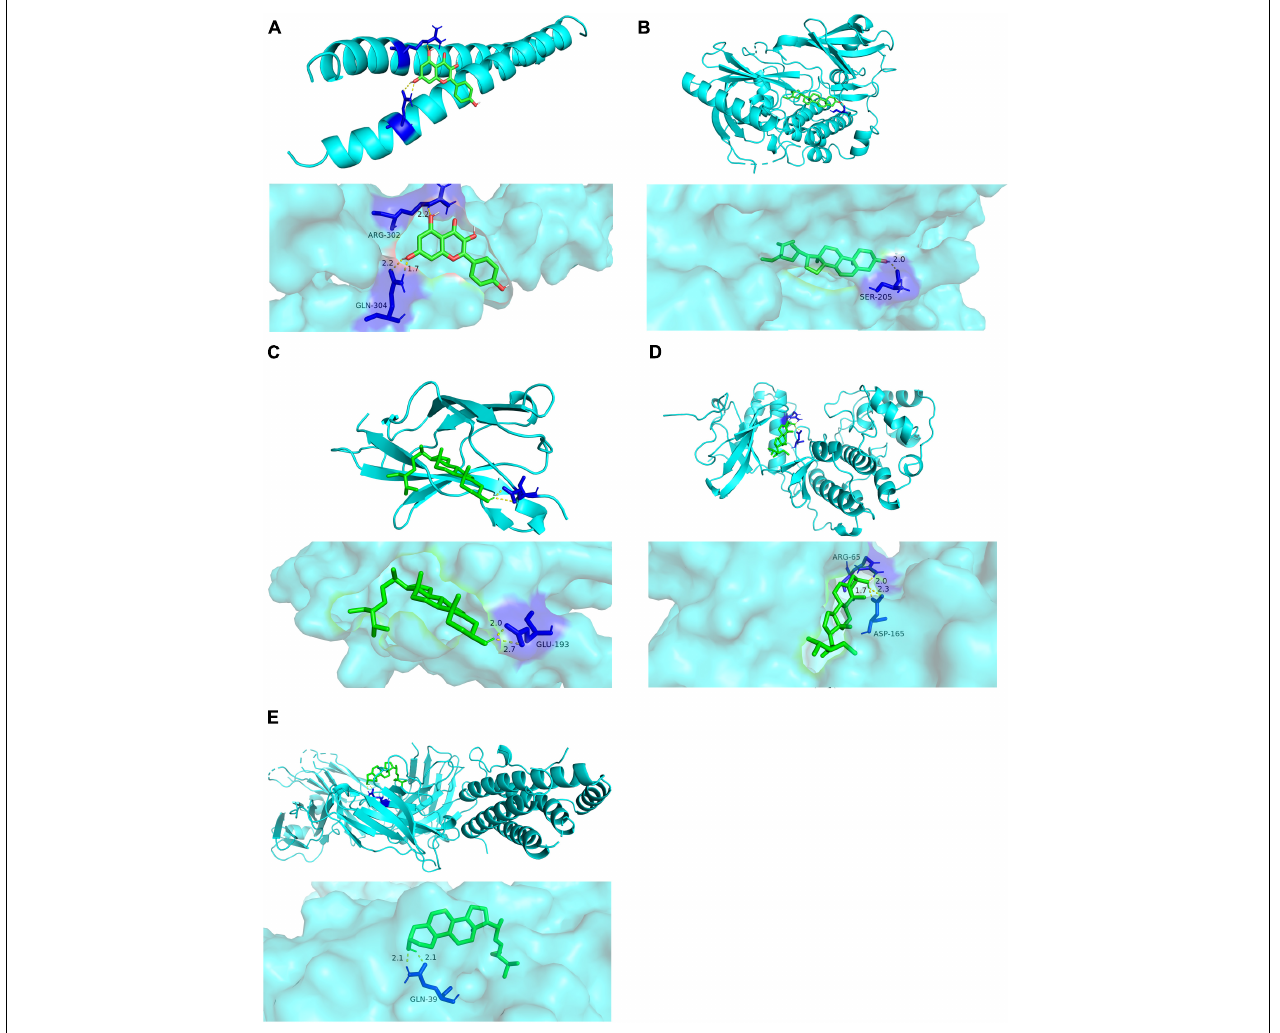
FIGURE 9 | Detailed target-compound interactions with the highest molecular docking affinities. (A) The binding pattern between JUN and kaempferol. (B) The binding pattern between AKT1 and beta-sitosterol. (C) The binding pattern between RELA and beta-sitosterol. (D) The binding pattern between MAPK1 and stigmasterol. (E) The binding pattern between IL6 and